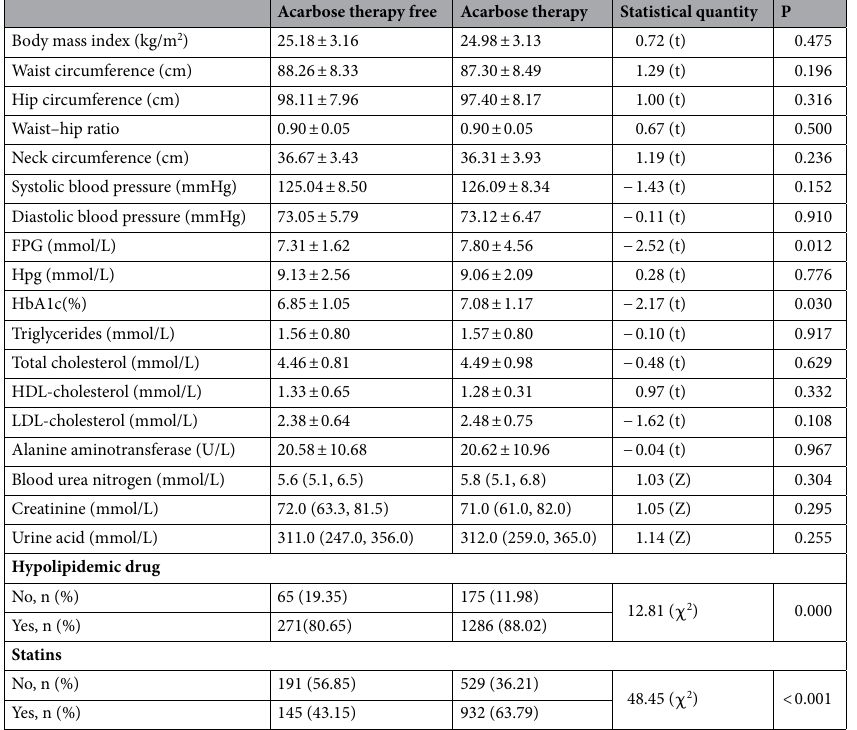
Table 2. Comparison of clinical characteristics between acarbose therapy free and acarbose therapy at end of study follow up (2018) in the Beijing Communities Diabetes Study (Report 24). N = number of individuals. Values are expressed as mean ± SD, median (Q1, Q3) or number (%). P statistical significance of the differences between the two groups. BMI body mass index, SBP systolic blood pressure, DBP diastolic blood pressure, TG triglyceride, TC total cholesterol, HDL-C high density lipoprotein cholesterol, LDL-C low density lipoprotein cholesterol, FPG fasting plasma glucose, Hpg 2-h postprandial blood glucose, HbA1c hemoglobin